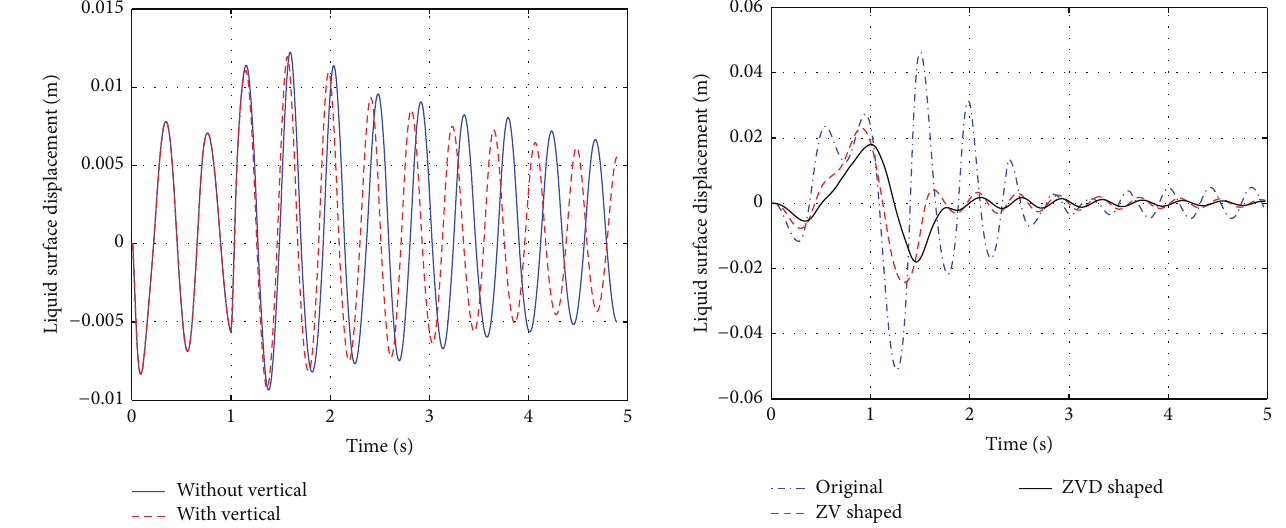
Figure 16: Comparison of sloshing in vertically dominant case.